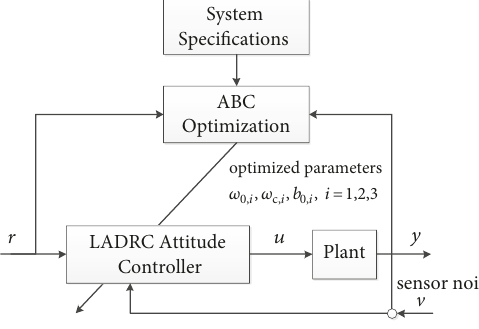
Figure 5: LADRC tuning scheme with